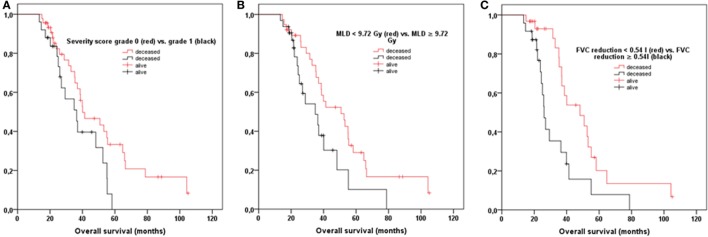
(A) Overall survival (OS) was significantly reduced if patients showed moderate/severe radiologic changes following stereotactic body radiotherapy (SBRT) compared to patients with only none/mild parenchymal changes (p = 0.043). (B) Patients with treated with an MLD ≥ 9.72 Gy suffered from worse OS (p = 0.042). (C) OS was significantly impaired if patients had an absolute reduction in FVC ≥ 0.54 L following SBRT (p = 0.007). FVC, forced vital capacity; MLD, mean ipsilateral lung dose in biological effective dose.